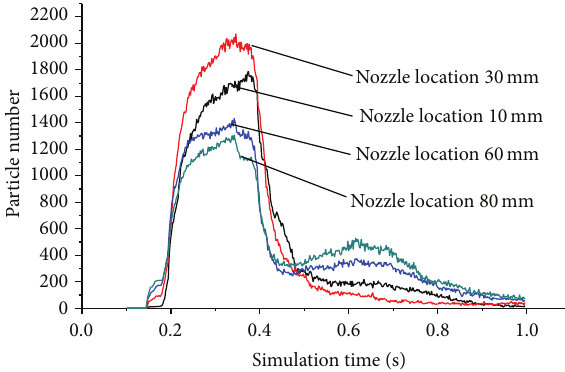
Figure 3: Part of particle trajectories.